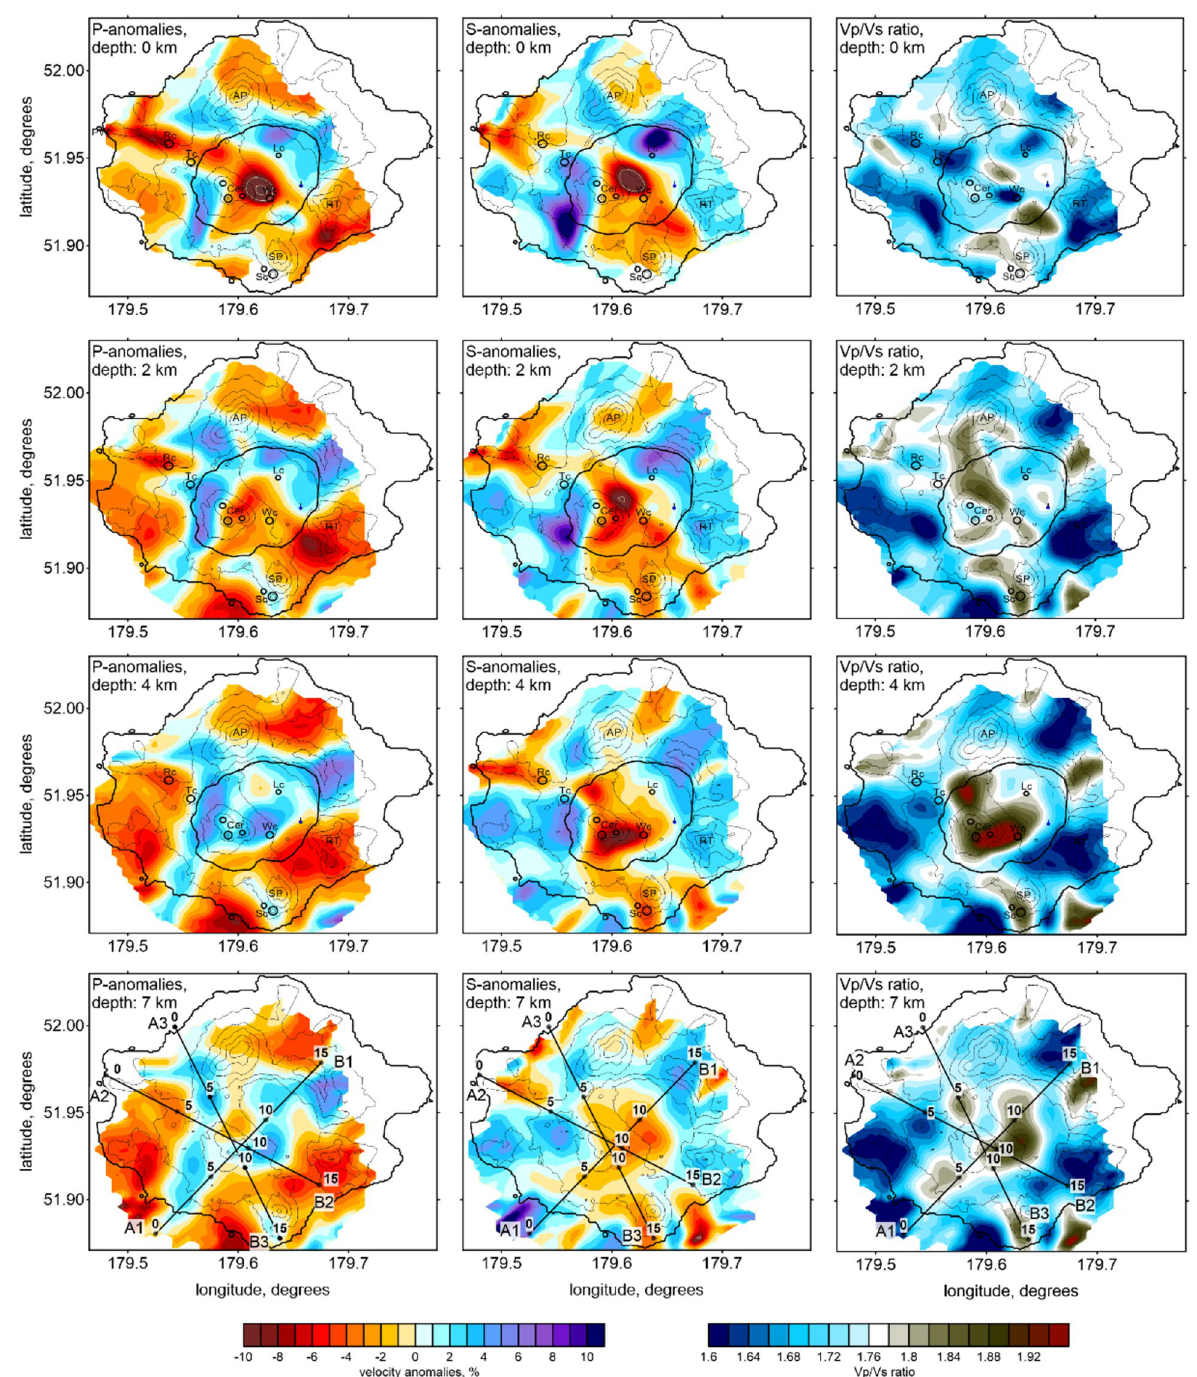
Figure 6. Distribution of the Vp and Vs anomalies and the Vp / Vs ratios obtained from the inversion of the experimental data in four horizontal sections. The locations of the vertical sections are indicated in the maps at a depth of 7 km. The topography is contoured at 200 m intervals. Cer cerberus stratovolcano, RC ringworm cone, Tc threequarter cone, Wc windy cone, Lc lakeshore cone, Sc sugarloaf cones, SP sugarloaf peak, AP anvil peak, RT ragged top. The figure was generated using the software Surfer (version 13, http:// www. golde nsofw are. com/ produ cts/